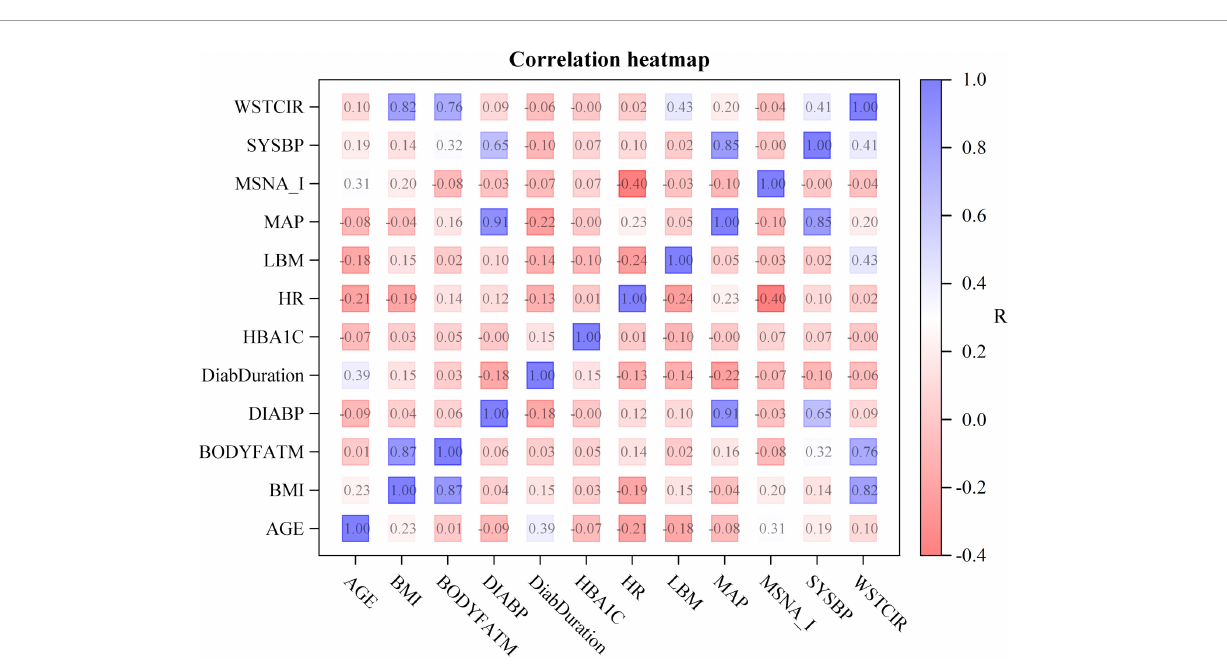
FIGURE3 Correlation heat map showing the relationship between clinical characteristics and muscle sympathetic nerve activity expressed as burst incidence (MSNA_I). The numbers denote uncorrected p -values for correlations between measurements. R -values are color coded as shown in the scale on the right. WSTCIR, waist circumference; SYSBP, systolic blood pressure; MAP, mean arterial pressure; LBM, lean body mass; HR, heart rate; HBA1C, hemoglobin A1C; DiabDuration, duration of diabetes mellitus; DIABP, diastolic blood pressure; BODYFATM, body fat mass; BMI, body mass